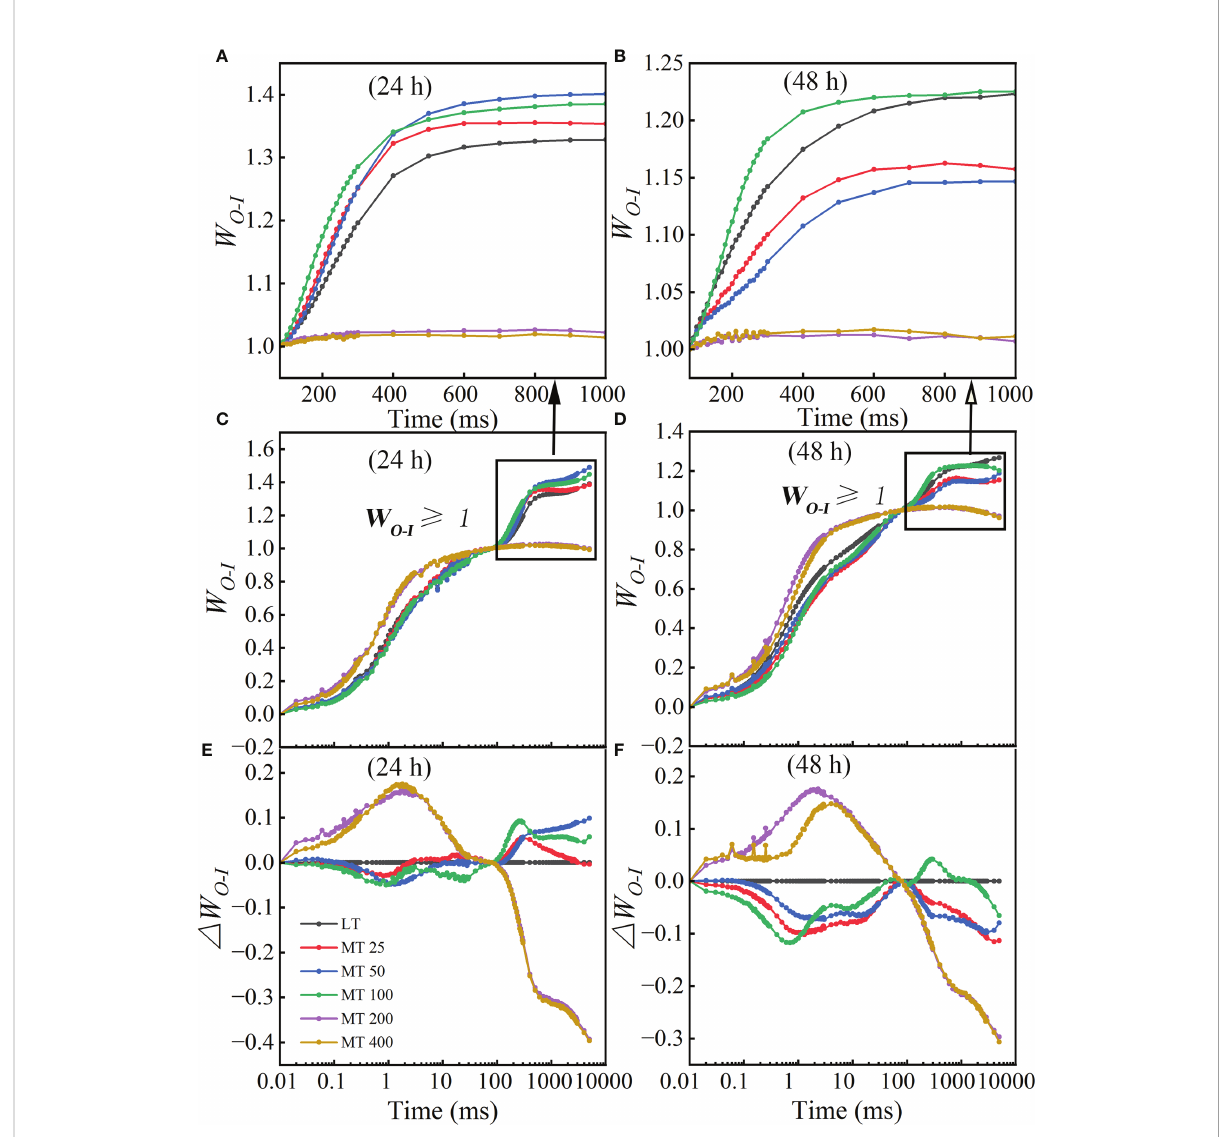
FIGURE 5 Different concentrations of melatonin (MT) induced the change in G-band shape in cucumber plants under low temperature stress. (A, B) The W O-I curves from 80 ms to 1000 ms after 24 h and 48 h of low temperature-stressed cucumber seedlings. (C, D) The OJIP curves were normalized by O and I points as W O-I = (F t – F O )/(F I – F O ). (E, F) The difference kinetics calculated as D WO-I = W O-I (treatment) – W O-I (control) in a logarithmic time scale. Data are presented as the means of three biological